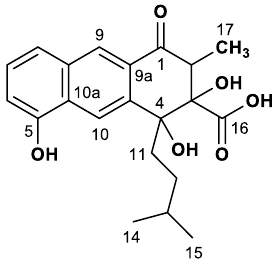
Figure 1. Structure of rishirilide B.